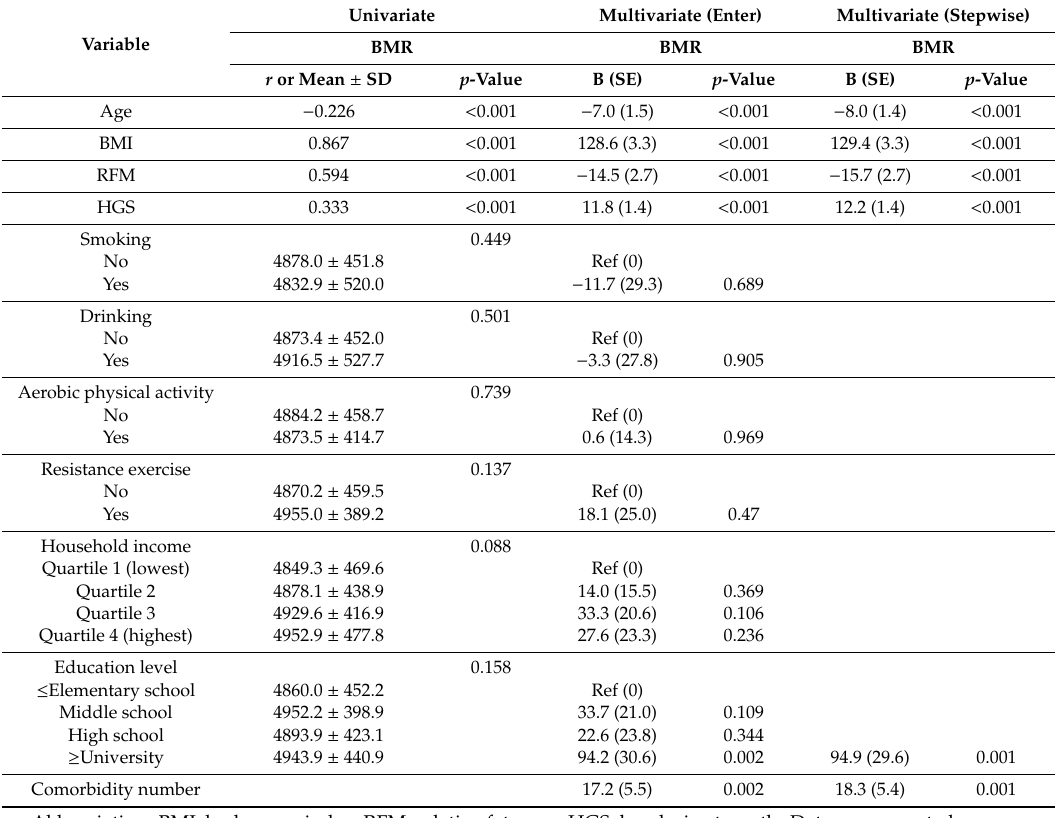
Figure 2. Plots of linear regression between basal metabolic rate and handgrip strength. The linear regressions are BMR (kJ / d) = 3824 + 64.2 × HGS ( r = 0.729). Table 4. Univariate and multivariate linear regression analysis of basal metabolic rate and studied variables in